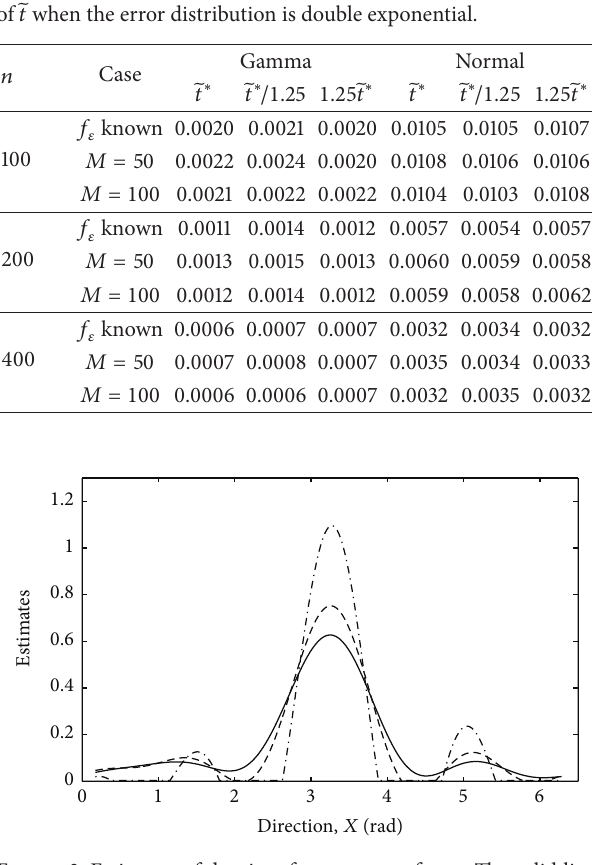
of the left side.